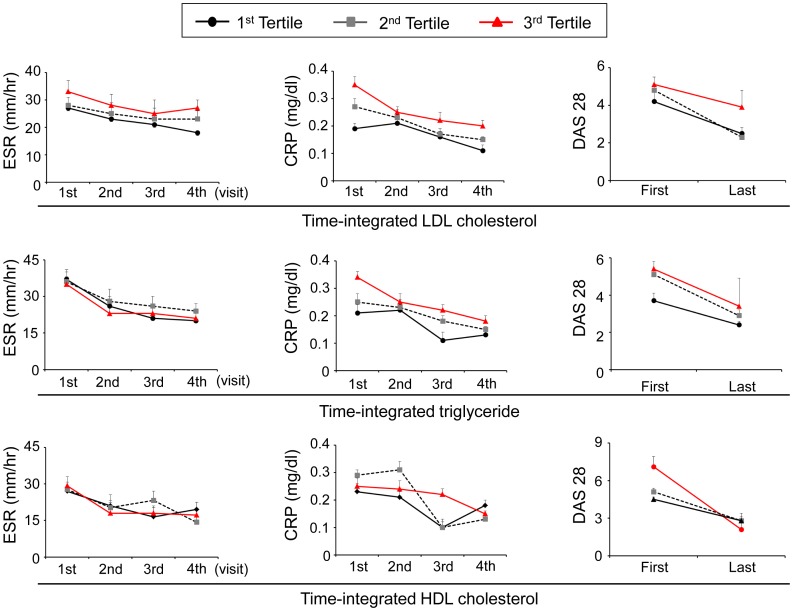
Changes in ESR, CRP level, and DAS28 during the follow-up period according to time-integrated lipid tertile.Patients with LDL cholesterol levels in the third tertile had persistently higher ESR levels (main effect of group: P<0.001, main effect of time: P<0.001, interaction effect: P<0.001), CRP levels (main effect of group: P<0.001, main effect of time: P<0.001, interaction effect: P<0.001), and DAS28 scores (main effect of group: P = 0.014, main effect of time: P = 0.016, interaction effect: P<0.001) than those with levels in the first tertile. Patients with triglycerides levels in the third tertile had higher CRP levels (main effect of group: P = 0.021, main effect of time: P<0.001, interaction effect: P<0.001) and DAS28 scores (main effect of group: P = 0.011, main effect of time: P = 0.016, interaction effect: P<0.001) than those with levels in the first tertile. No difference was found in ESR, CRP, and DAS28 according to HDL cholesterol levels. Values are expressed as mean±SD. P-values are calculated by ANOVA repeated measures. See the Table 1 for abbreviations.